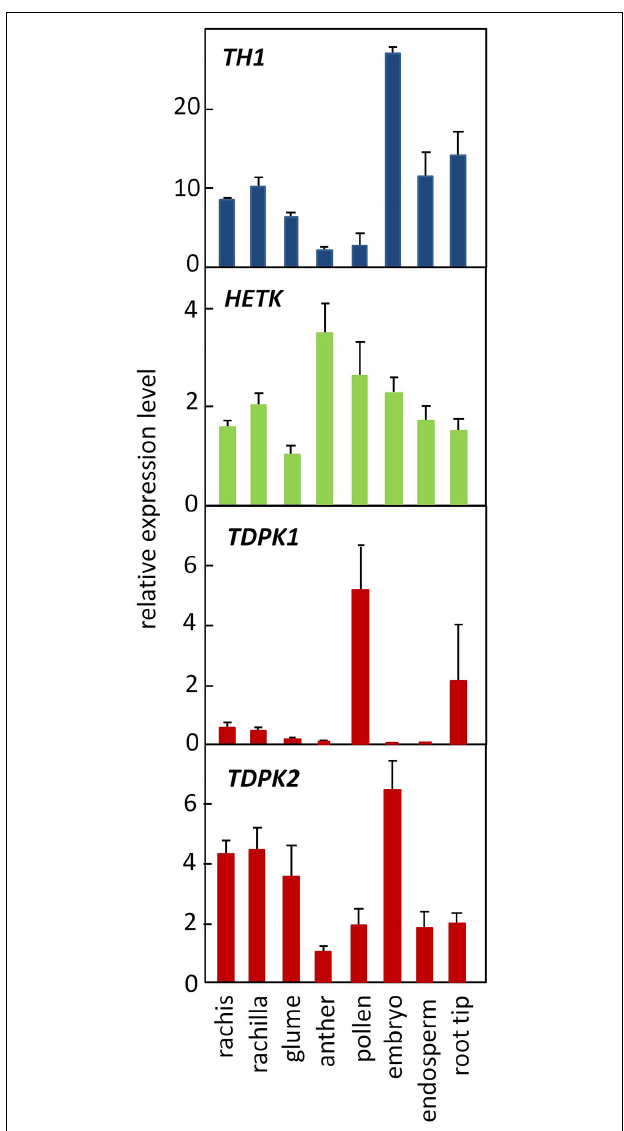
FIGURE 8 | Genes encoding thiamin assembly and salvage steps are ubiquitously expressed in maize. TH1 (blue), TDPK1 and TDPK2 (red) function in primary synthesis and thiamin salvage pathways. HETK functions in thiazole salvage. Error bars are standard error of the mean ( n =